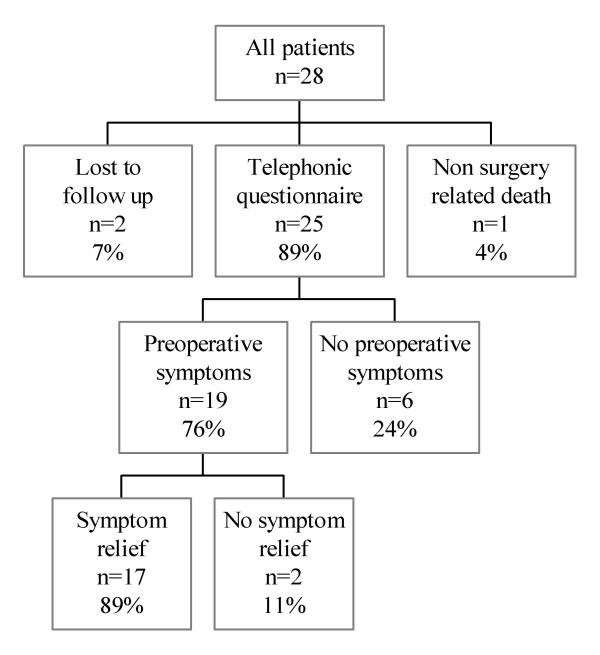
Patients summary